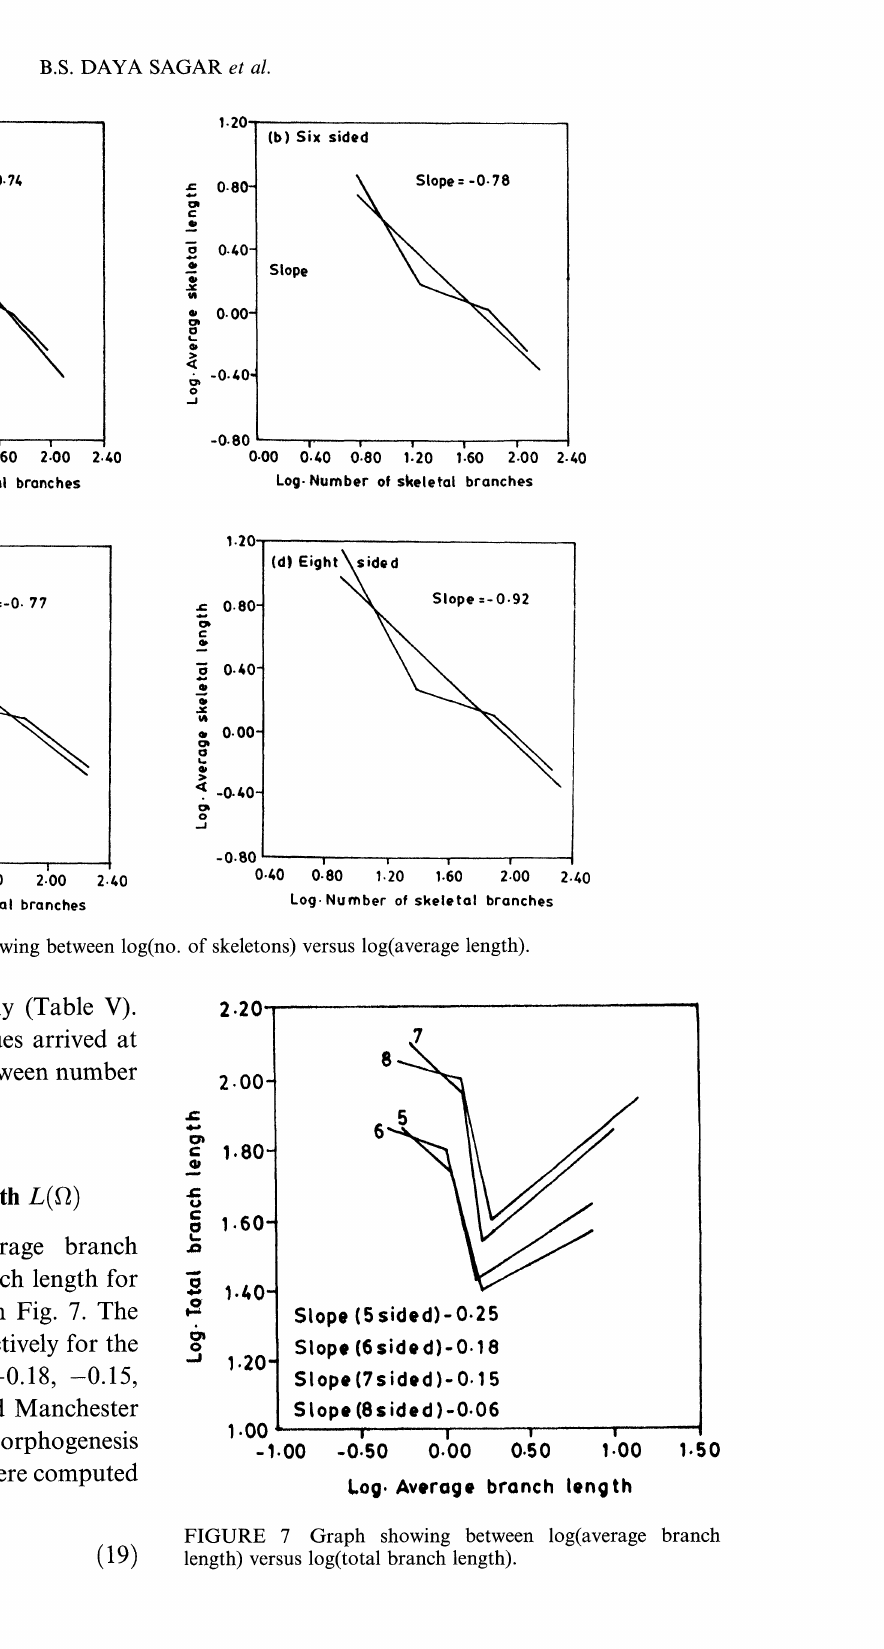
FIGURE 7 Graph showing between log(average branch length) versus log(total branch